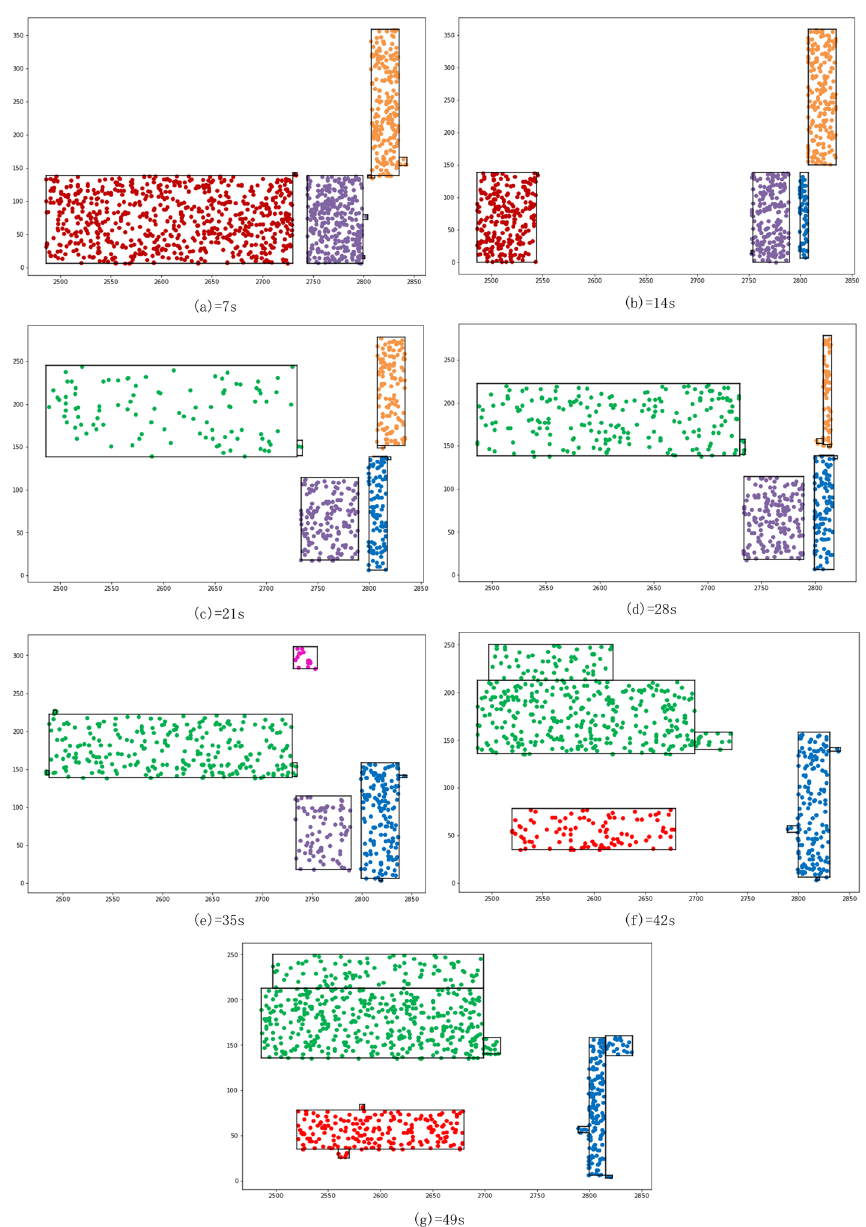
represents a snapshot of clustering resultat a certain time. Data points of dierent color belong to dierent